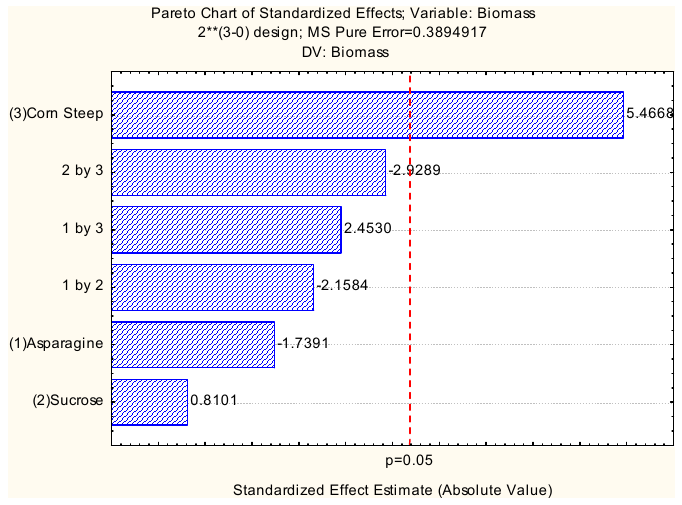
Figure 1. Pareto Chart of standardized effects for 2 3 full factorial design when the independent variables are: (1) asparagine (2) sucrose (3) corn steep liquor, and (4) corn steep concentrations as a response variable on biomass production by Cunninghamella elegans .